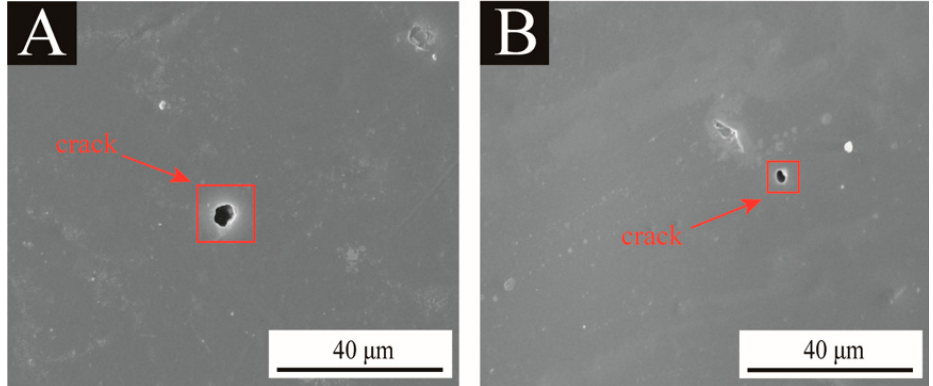
Figure 12. SEM images of coating without and with microcapsules after aging at 120 °C in oven: ( A )